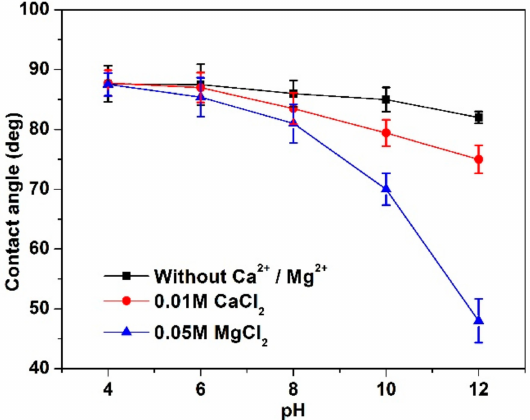
Figure 7. Contact angle of MoS 2 surface at different pH.